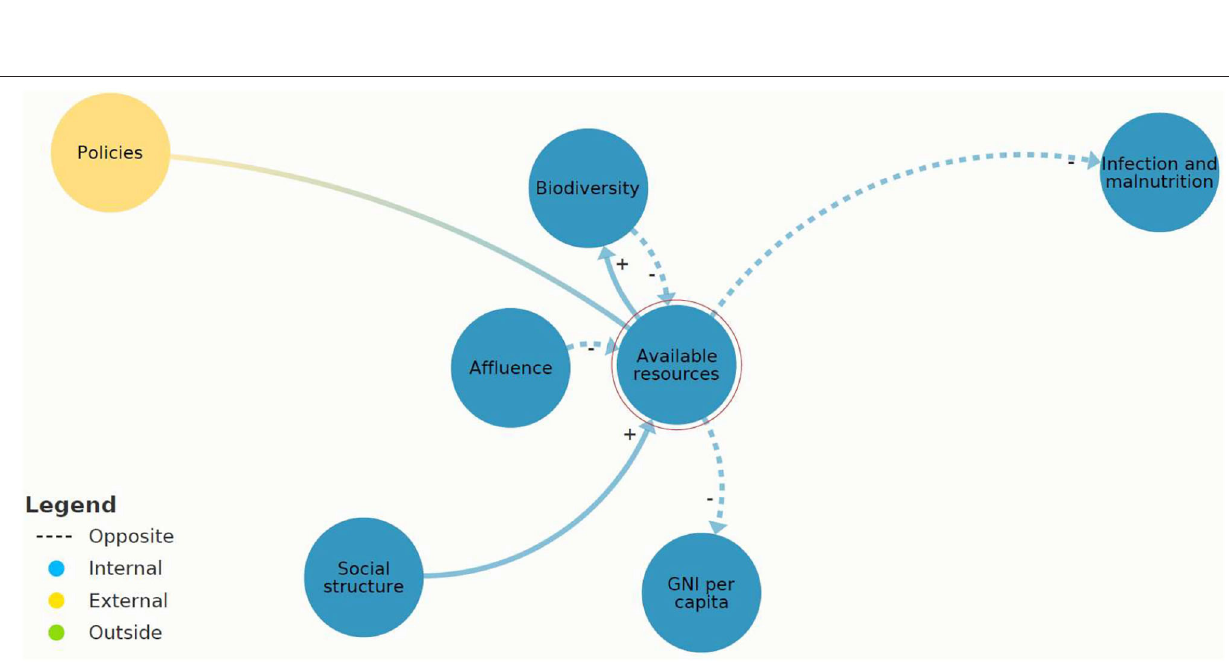
Frontiers in Public Health |